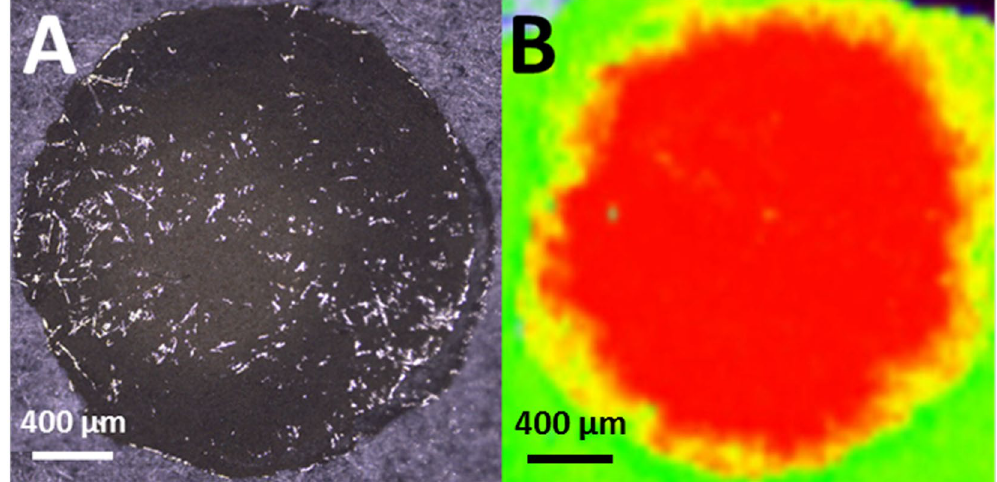
Figure 7. ( A ) Microscopic image of the SERS substrate on office paper. ( B ) Distribution of R6G molecules (red colour) across the entire area of the well in the plasmonic paper substrate obtained by Raman Imaging. Due to the extremely fast drying of the drop, R6G molecules are uniformly distributed on the well. The intensity of the red colour is proportional to the 1509 cm − 1 vibrational line intensity from R6G. The green shows the absence of R6G